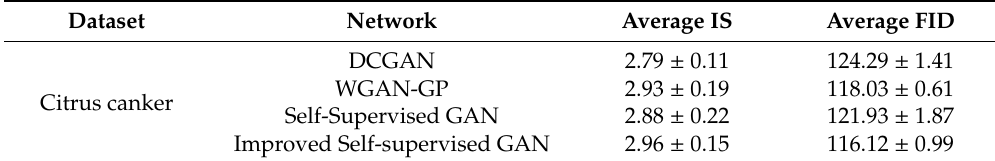
Table A1. IS and FID of the complete lesion leaf image generated by DCGAN, WGAN-GP, self-supervised GAN and improved self-supervised GAN for 997 training images after training for 100,000 iterations. We gathered statistics for 10 exercises, and the di ff erence was statistically significant ( p < 0.05).